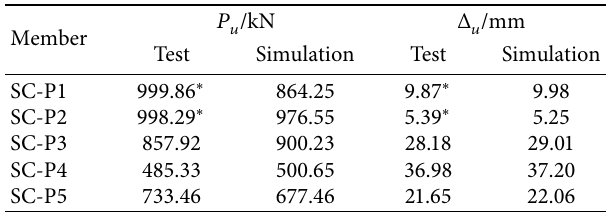
Figure 27: Load-deformation curves of all members. Table 7: Comparison between the test result and the simulation